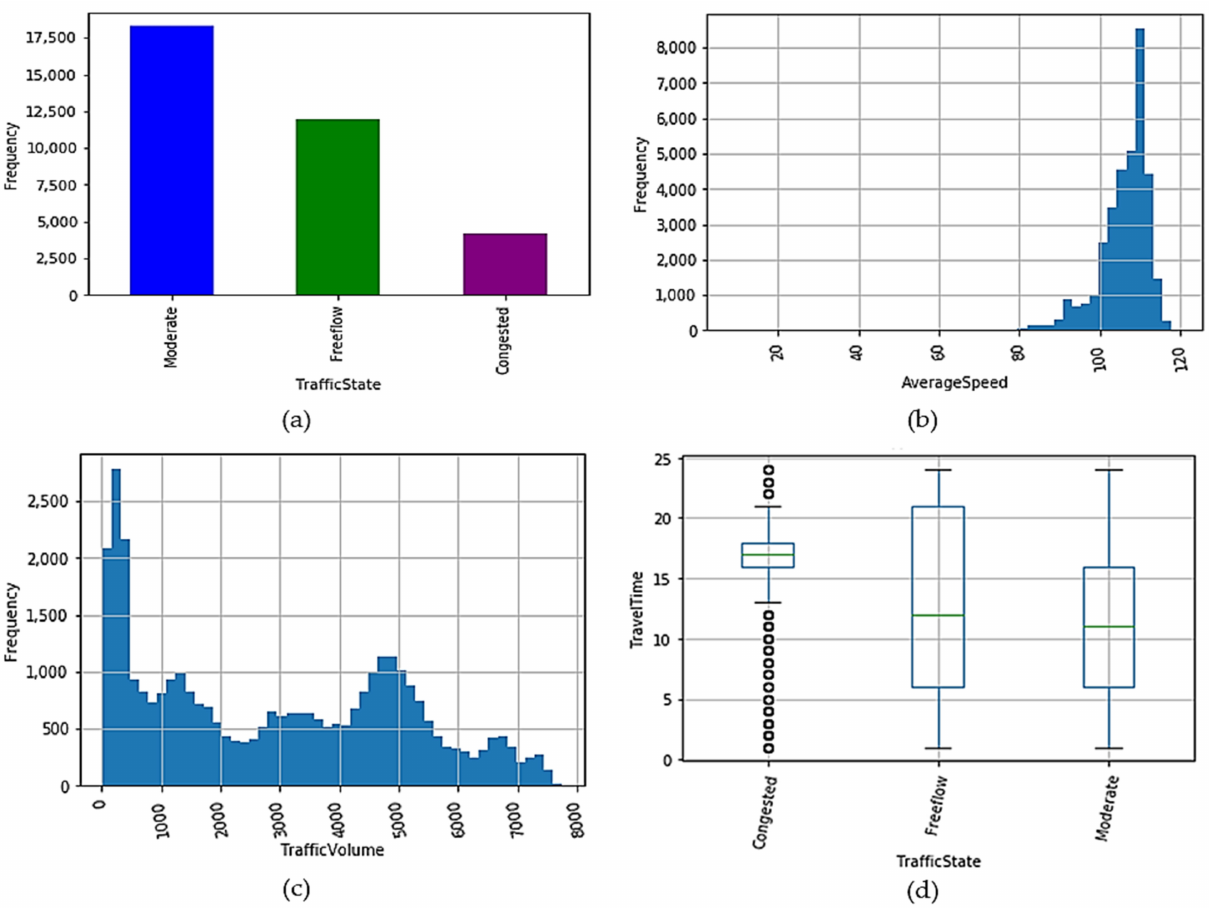
Figure 2. Summary analysis plots for RTC dataset. The three TrafficStates known as Congested , Freeflow , and Moderate ( a ); AverageSpeed ( b ); TrafficVolume ( c ); TrafficState ( d